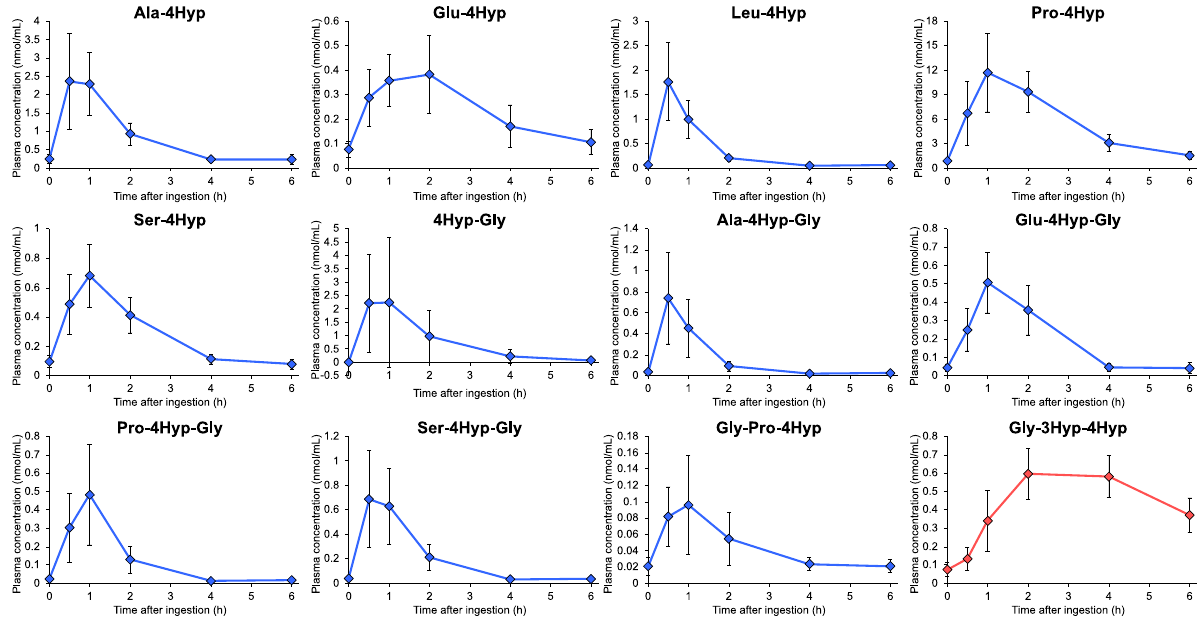
Fig. 3 Concentrations of Hyp-containing oligopeptides in human plasma after oral ingestion of collagen hydrolysate. Human plasma samples collected before (0 h) and 0.5, 1, 2, 4, and 6 h after the ingestion of porcine skin collagen hydrolysate were analyzed by LC − MS in MRM mode. The data represent the mean ± SD ( n = 8).